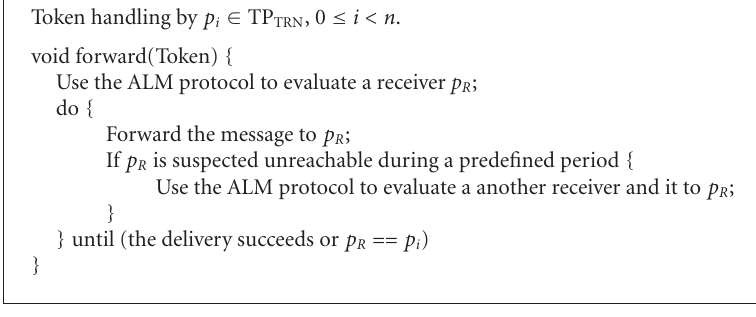
Algorithm 1: Rule to forward a token.